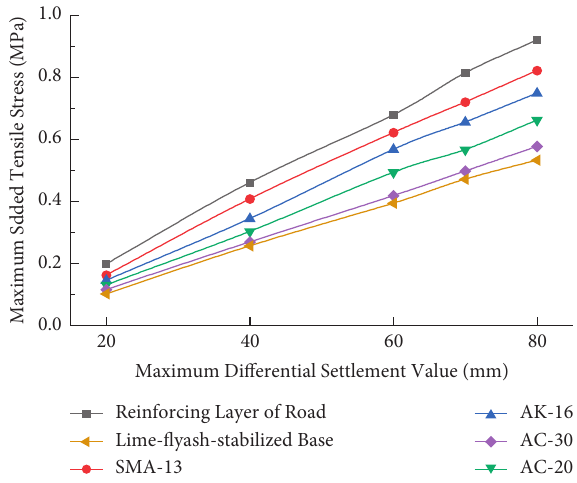
Figure 20: Maximum tensile stress of the old pavement structure layer under different difference settlement. Table 6: Calculation results of maximum tensile stress of structural layer of the old pavement under different differential settlements (MPa). Pavement structural layer